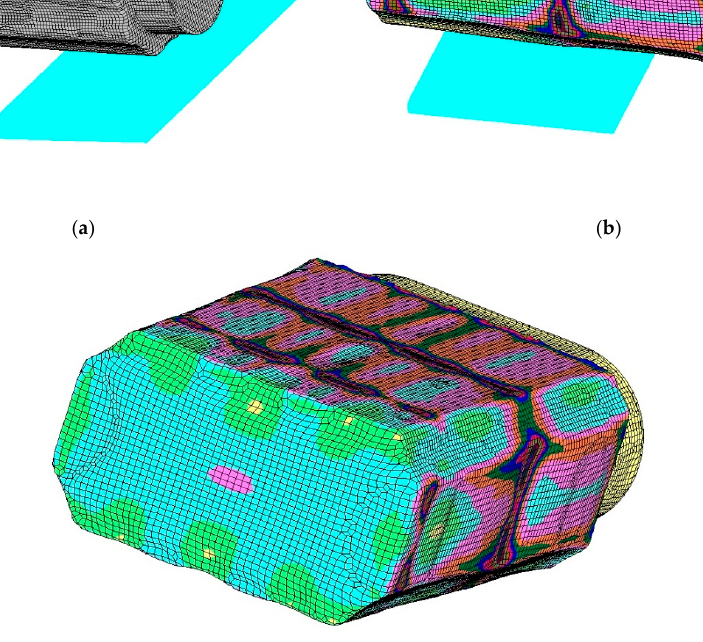
Figure 4. Effective plastic strain distribution calculated by numerical simulation of forging the plate with 310 mm of thick- ness from the P40N slab ingot. 3.2. Results of Forging of Conventional 8K Polygonal Ingot The forged tong hold and a parallel octagon body of the original 8K polygonal ingot is documented in Figure 5a. Figure 5b shows the upsetting of a conventional 8K polygonal ingot. The cross section clearly shows the uneven course of effective plastic strain typical for upsetting. The result of uneven deformation is the creation of additional tensile stresses on the side surface of the upset body, undesirable shape change of the side walls